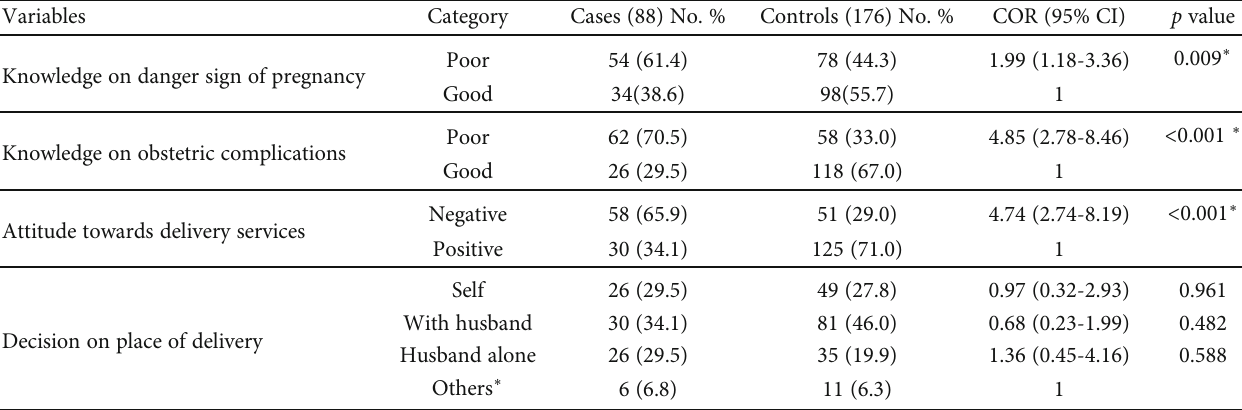
Table 2: Bivariate analysis of knowledge, attitude, and decision on place of delivery among cases and controls in Abobo Woreda, Gambella region, Southwest Ethiopia, 2019.